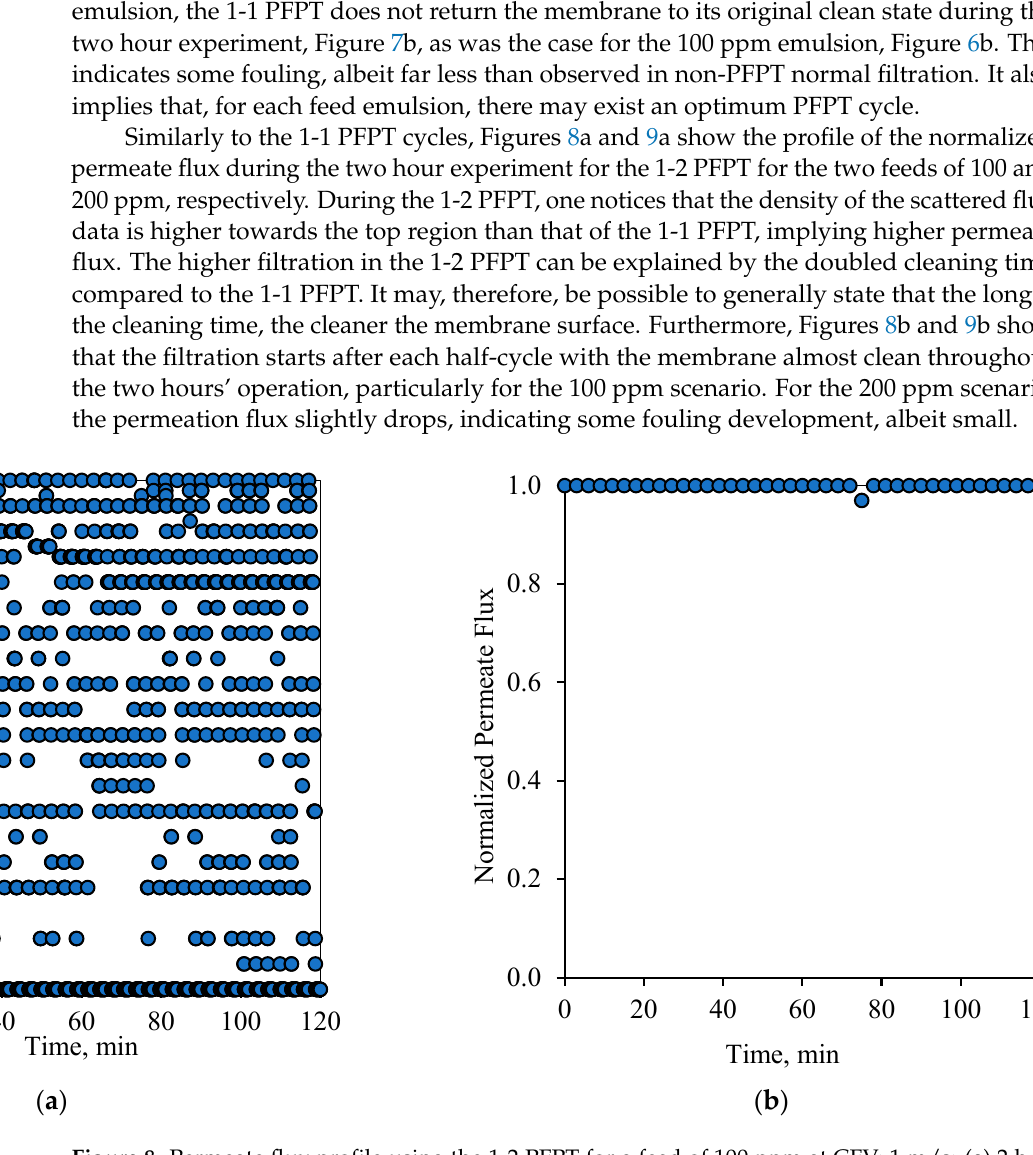
Figure 7. Permeate flux profile using the 1-1 PFPT for a feed of 200 ppm at CFV: 1 m/s: ( a ) PFPT filtration mode, ( b ) membrane permeability after each cleaning half-cycle.